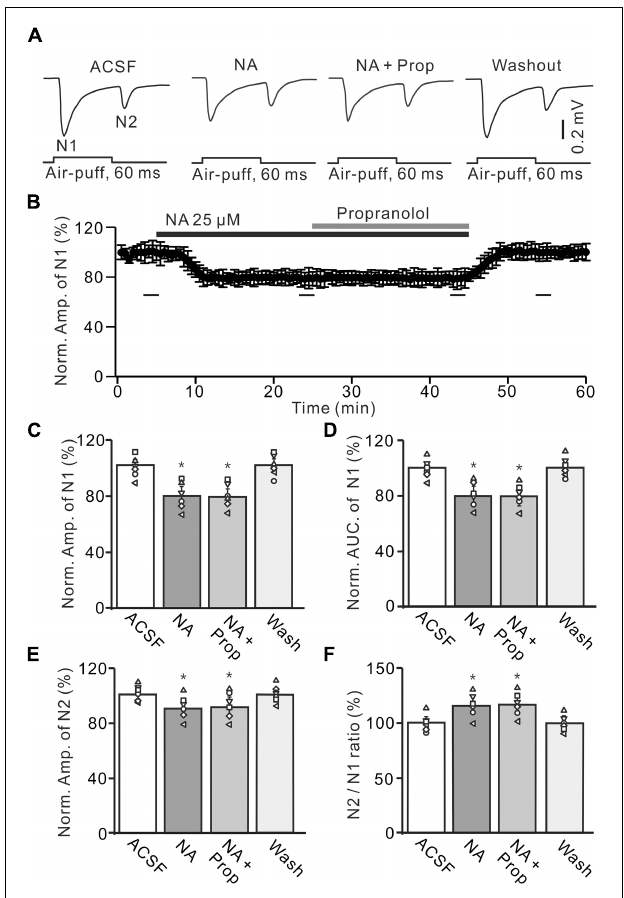
FIGURE 4 | Application of α 1-AR blocker, prazosin failes to reverse the NA-induced depression of the facial stimulation-evoked MF-GC synaptic transmission. (A) Representative field potential traces showing the facial stimulation (60 ms, 60 psi) evoked MF-GC synaptic transmission in a mouse cerebellar GL during treatment with ACSF, NA (25 µ M), NA + prazosin (Praz; 50 µ M), and recovery (washout). (B) Summary of data showing the time course of normalized amplitude of N1 during treatment with ACSF, NA, NA + prazosin (Praz; 50 µ M) and recovery (washout). Bars denote the data points which were used in the bar graphs (C–F) in treatments with ACSF, NA, NA + prazosin and washout. (C,D) Mean value ( ± SEM) with individual data showing the normalized amplitude (C) and AUC (D) of N1 during each treatment. (E,F) Mean value ( ± SEM) with individual data showing the normalized amplitude of N2 (E) and the N2/N1 ratio (F) for each treatment. * p < 0.05 versus control (ACSF); n = 6 in each group. 81.1 ± 5.7% of baseline [ACSF: 100.4 ± 4.0%; F (3, 54) = 13.92, P = 0.023; n = 6], which was not significantly different from